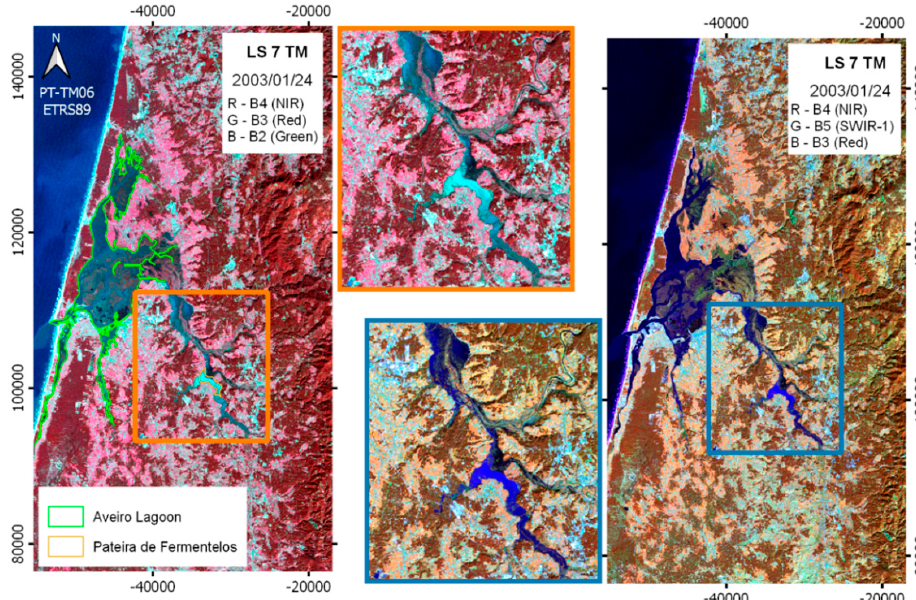
Figure 4. False-color RGB composites of Landsat 7 (LS7) TM bands, acquired 5 days after the 19/01/2003 flood event (26.5 return period). (Coordinate system: PT-TM06/ETRS89).